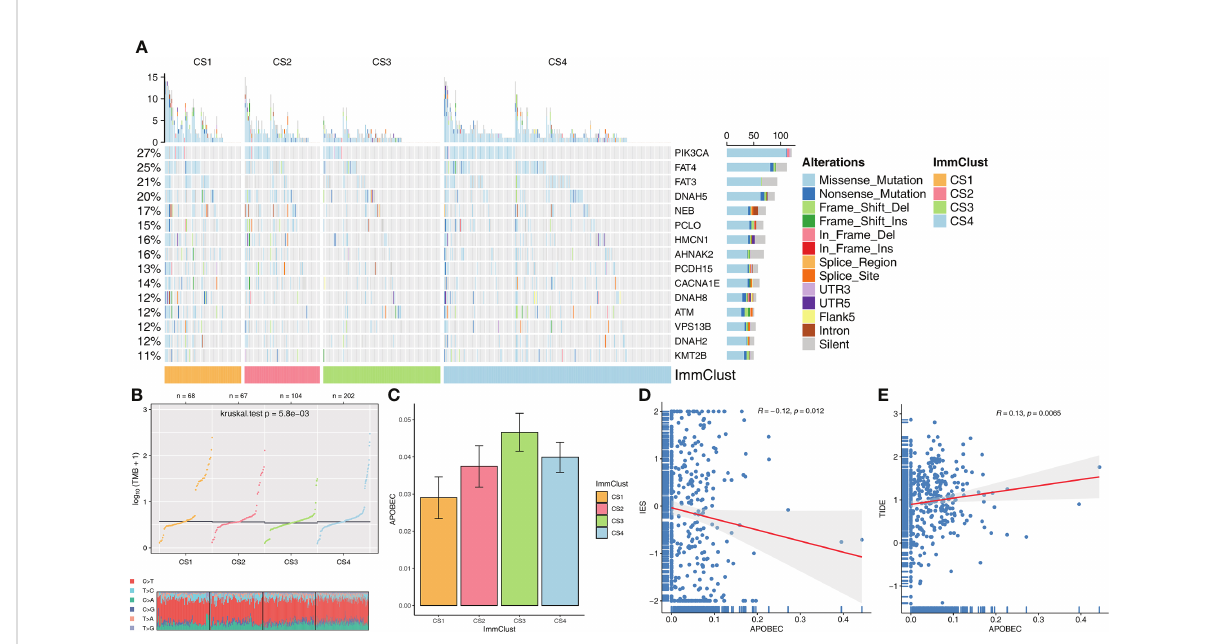
FIGURE 5 Evaluation of mutation differences among the four ImmClusts. (A) The waterfall plot of somatic mutation features established with ImmClusts. (B) TMB and distribution of TiTv calculated by MOVICS for the four ImmClusts. (C) Apolipoprotein B mRNA-editing enzyme catalytic polypeptide-like (APOBEC) mutation weights of the four ImmClusts. (D) Correlation between immune enrichment score (IES) and APOBEC mutation weight. (E) Correlation between TIDE score and APOBEC mutation